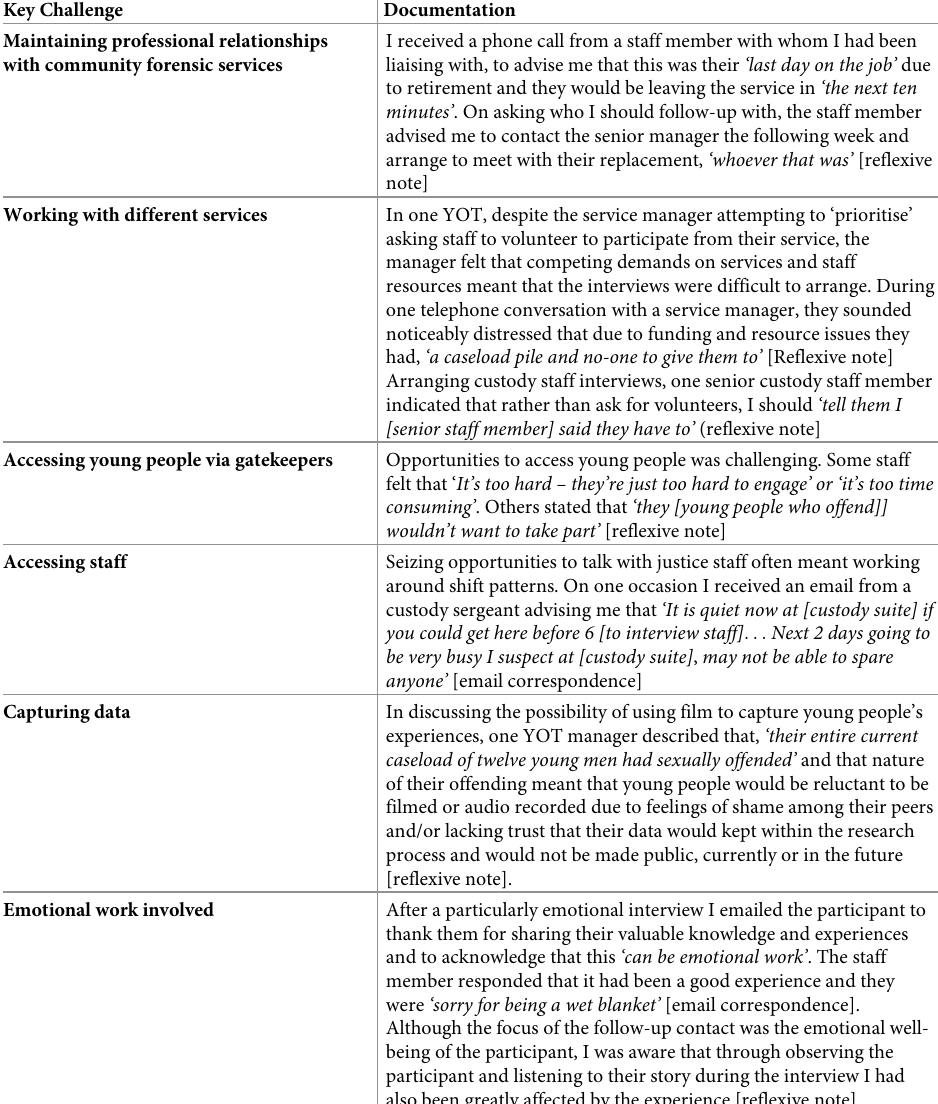
Table 3. Experiential learning from the EBCD methodological study: Some key challenges. Key